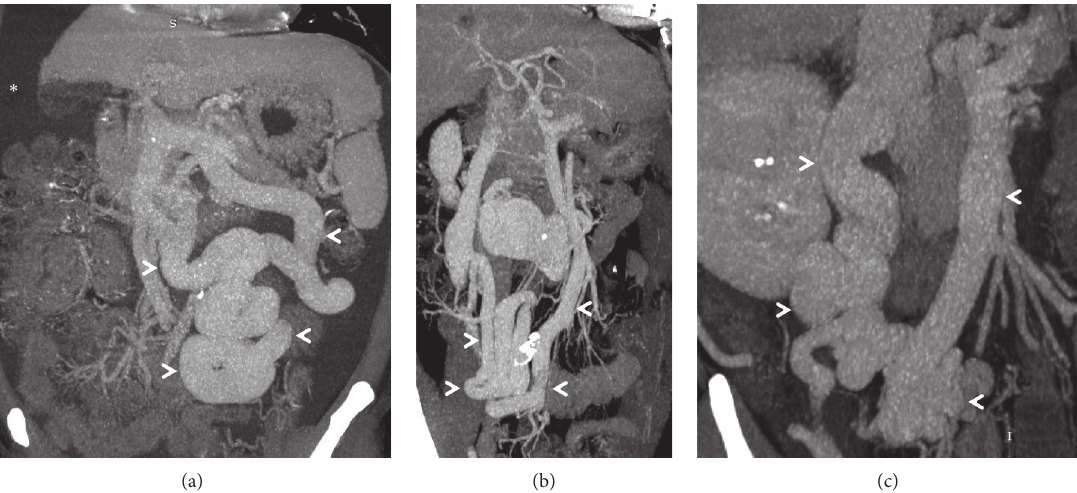
Figure 4: Coronal-oblique MIP images from three different patients (a–c) depicting mesocaval shunts (arrowheads). Afferent vessel for shunt shown in (a) is inferior mesenteric vein while feeder for shunts shown in (b) and (c) is superior mesenteric vein. Note. The presence of ascites (asterisk) in